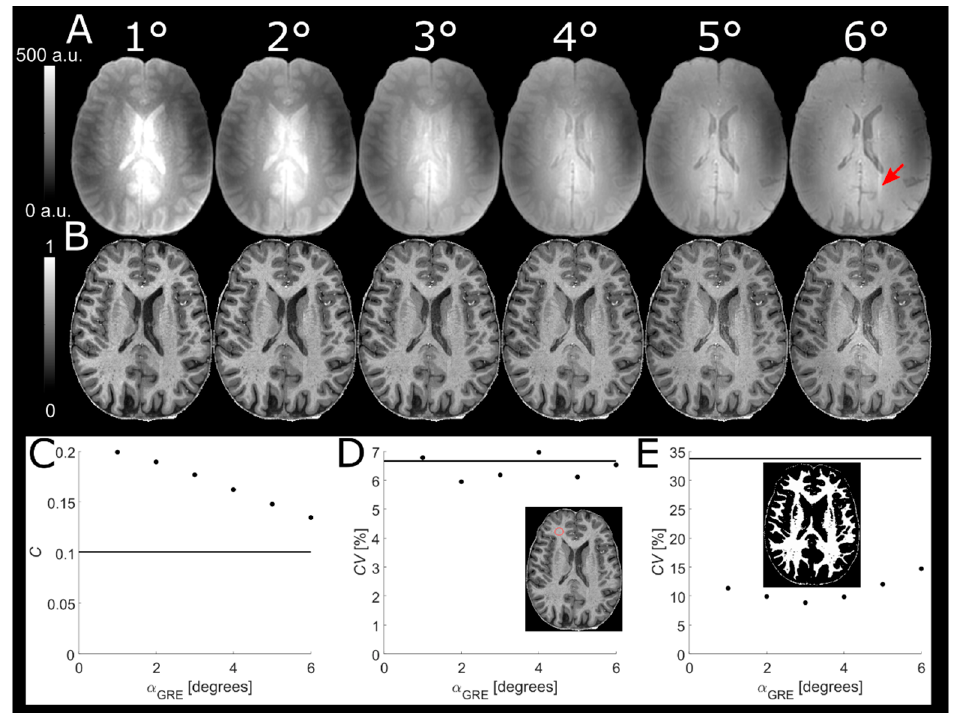
Figure 1. Reference GREs with different α GRE (top row, ( A )) used to obtain normalized MPRAGE volumes (middle row, ( B )). Decreasing WM-GM contrast with increasing α GRE is evident from visual inspection of the normalized volumes and verified in the scatter plot ( C ). No change in SNR could be identified by the CV in a WM ROI (red circle) ( D ). The CV in whole segmented WM had a minimum at α GRE = 3°, implying minimum influence from residual B 1+ effects ( E ). These residual B 1+ effects are visually identifiable as hyperintense pixels in the center of the normalized MPRAGE for α GRE = 6° (B). The solid lines in the scatter plots represent the respective MPRAGE volume values before normalization. In this experiment, the dielectric pads caused a visible fold-over artefact (red arrow).